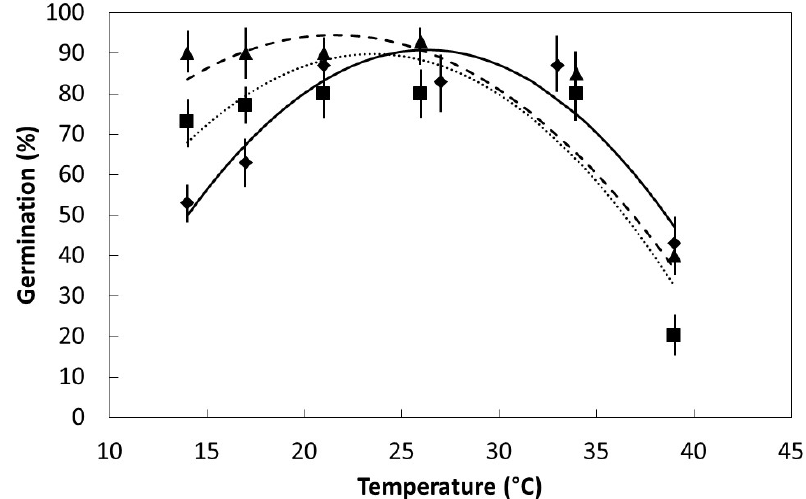
Figure 3. The influence of temperature on germination percentage for Serianthes species. Mean ± standard error, n = 6. Serianthes grandiflora (squares, dotted line), y = −43.2 + 11.3 x − 0.24 x 2 , r 2 = 0.86 ; Serianthes kanehirae (triangles, dashed line), y = 6.0 + 8.2 x − 0.19 x 2 , r 2 = 0.90 ; Serianthes nelsonii (diamonds, solid line), y = −95.9 + 14.2 x − 0.27 x 2 , r 2 = 0.90.